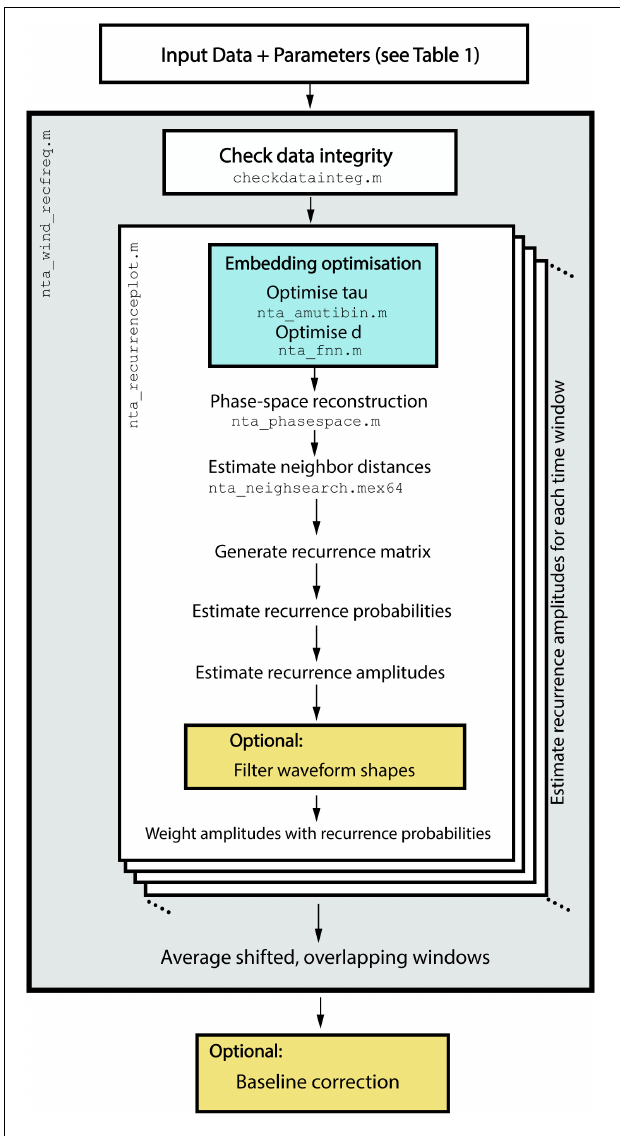
FIGURE 8 | Workflow of the implemented algorithms in nta_wind_recfreq.m. After time series data and the configuration structure are passed to